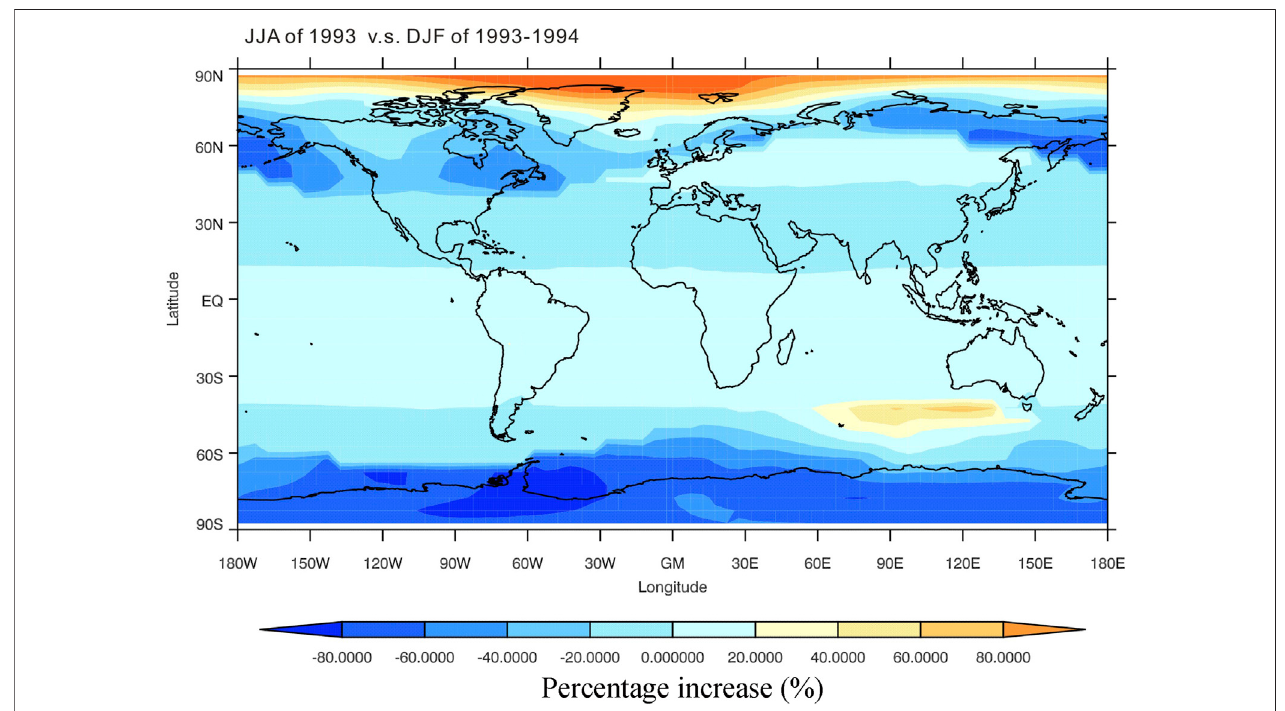
FIGURE 9 | The percentage increase in column resistance between JJA 1993 and DJF 1993 –